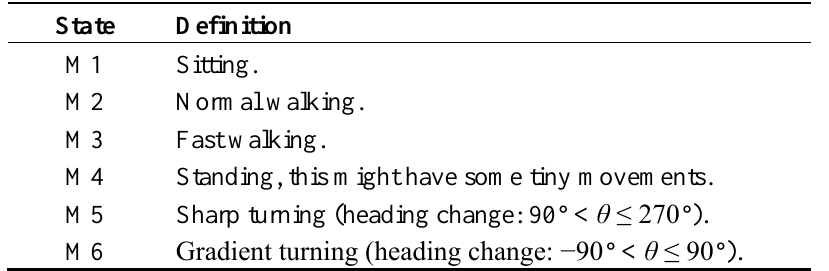
Table 1. Motion state definition.